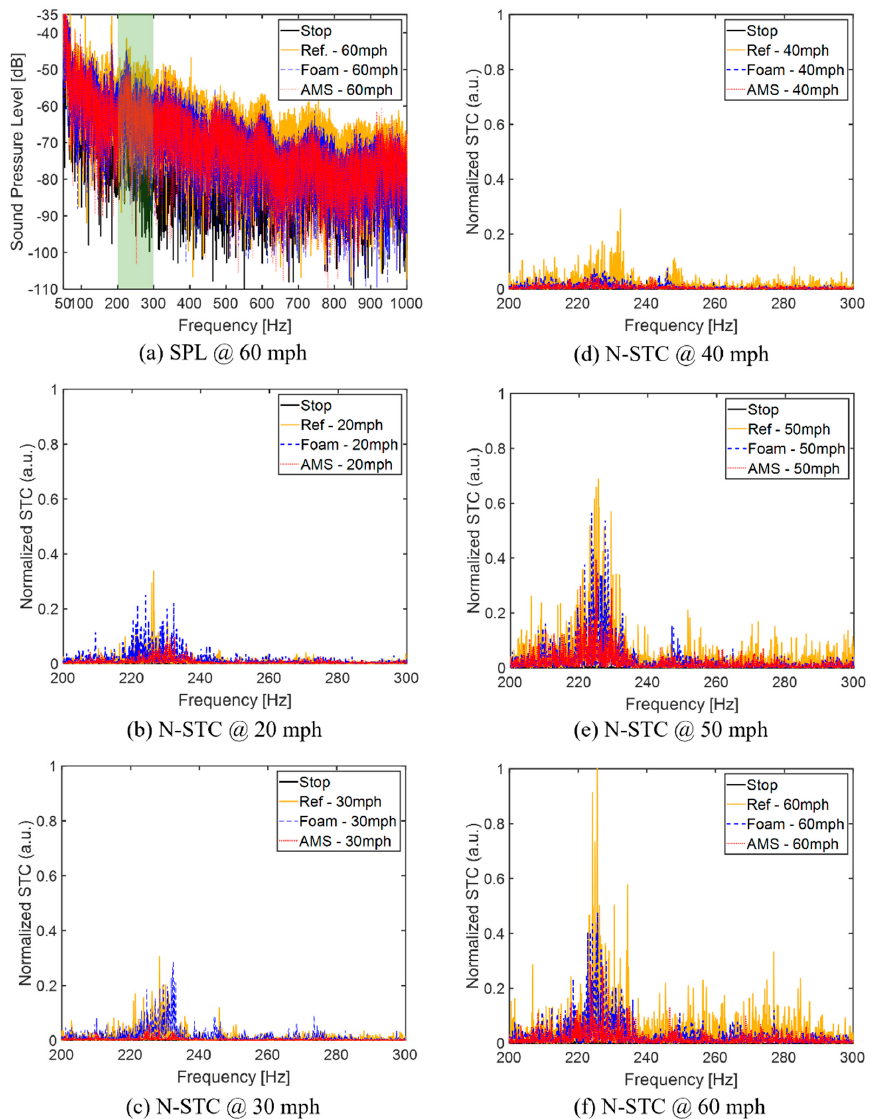
Figure 6. The result of the sound reduction performance of the AMS (red) and the foam (blue) compared to the original tire (yellow) without any attachment through the field test. ( a ) The sound pressure spectra from 100 Hz to 1000 Hz. The solid black line represents the stopped state. At 60 mph, yellow (solid), blue (dashed), and red (dotted) lines represent no attachment, foam attachment, and AMS on the rim, respectively. ( b – f ) The normalized sound transmission coefficients (N-STC) from 200 Hz to 300 Hz depending on the vehicle speed.